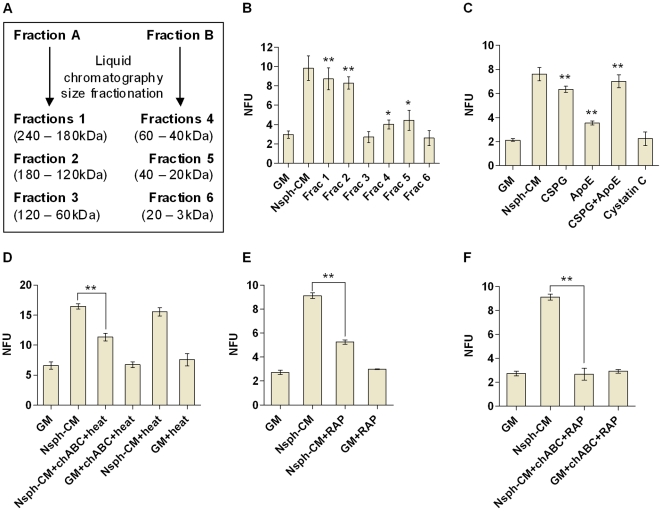
CSPG and ApoE are the components of nsph-CM responsible for stimulation of nsph formation.(A) Fractions A and B of nsph-CM were further fractionated into six fractions by size using liquid chromatography as shown. Cells were plated at 2×103 cells/ml and NFUs measured after five days of culture as described in figure 1 with the following variations; (B) Addition of GM, nsph-CM or sub-fractions 1–6. Nsph-CM and sub-fractions 1–6 were reconstituted into GM to the original concentration prior to cell culture. (C) Addition of GM, nsph-CM, CSPG (50 µg/ml), ApoE (50 nM) or cystatin C (20 ng/ml). (D) Addition of GM and nsph-CM alone with and without heat inactivation, or GM and nsph-CM pre-digested with chABC (50 mU/ml) and heat inactivated. (E) Addition of GM and nsph-CM with and without recombinant receptor associated protein (RAP; 5 µM). (F) Addition of GM, nsph-CM, with and without chABC (50 mU/ml) treatment (including heat inactivation, see Materials and Methods) and RAP (5 µM). Data are presented as mean ± SEM with n = 4–11 (from 2–4 experiments); *P≤0.05, **P≤0.01 compared to GM or as indicated on the graphs.